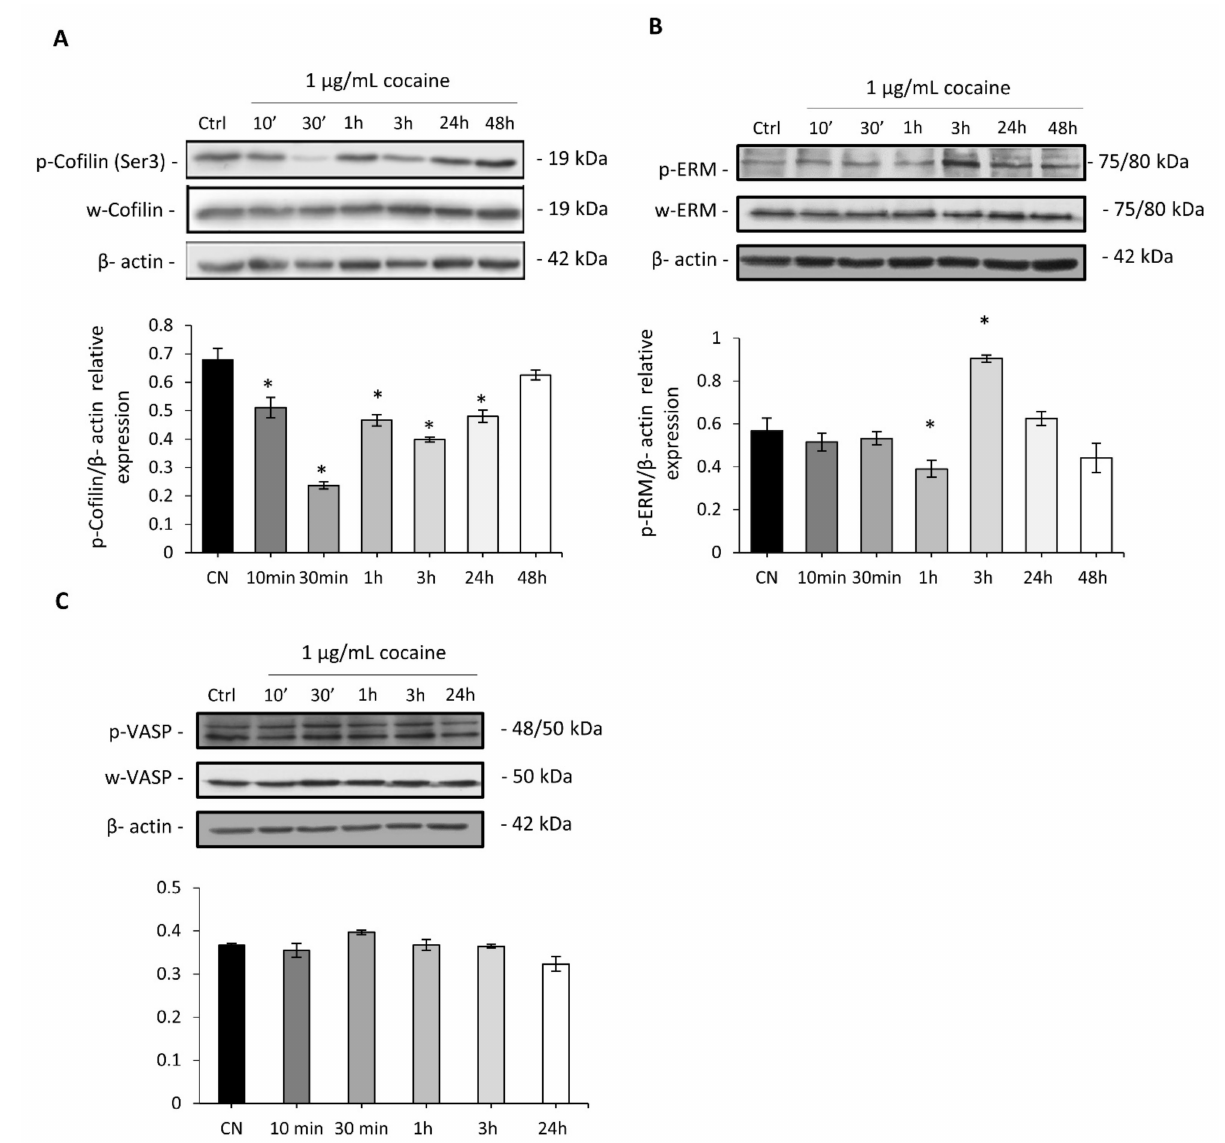
Figure 4. H9c2 cardiomyocyte ABP expressional changes mediated by cocaine exposure without treatment renewal by immunoblotting using ABP specific antibodies. ( A ) Phospho-cofilin (Ser-3) expression changes following short- and long- term exposures regulated several time-point specific changes. ( B ) Phospho-ERM (Thr-567, Thr-564, and Thr-558) expression changes following time course specific cocaine treatments. ( C ) Expression of phospho-VASP at the Ser-239 specific site showed no change to control when treated with cocaine. ( A – C ) representative immunoblots of three lysates generated from three independent experiments. Densitometry indicating relative band expression for each blot measured using ImageJ with corresponding statistical analysis performed (One way ANOVA), in all cases * p < 0.05 for treated vs